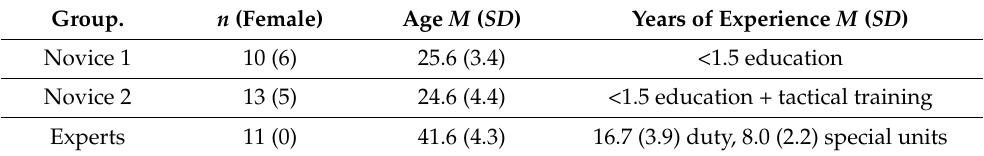
Table 1. Demographic information.